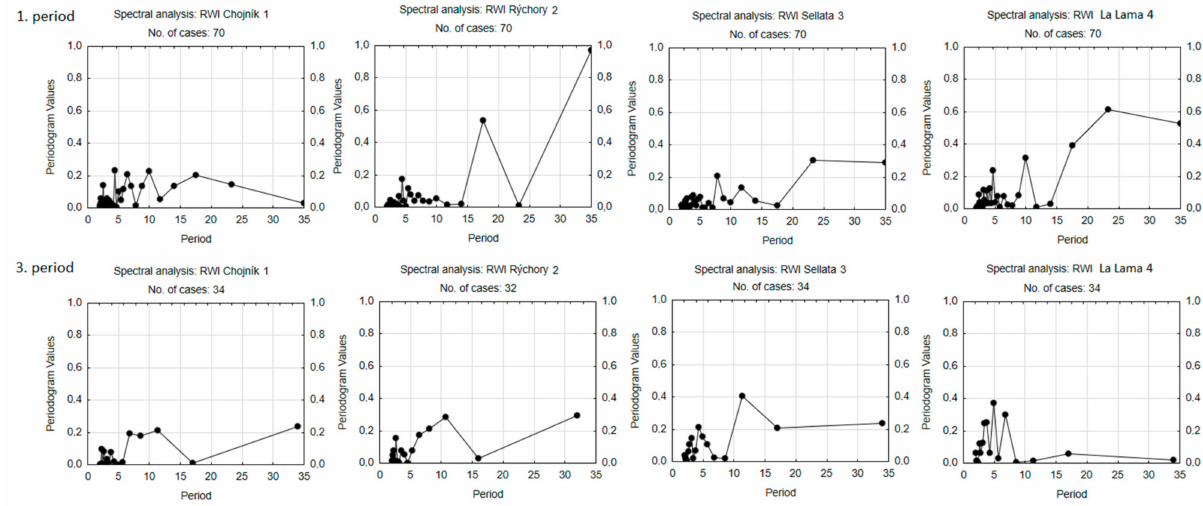
Figure 5. Single spectral analysis of the indexed ring-width chronology for European beech in the first and third